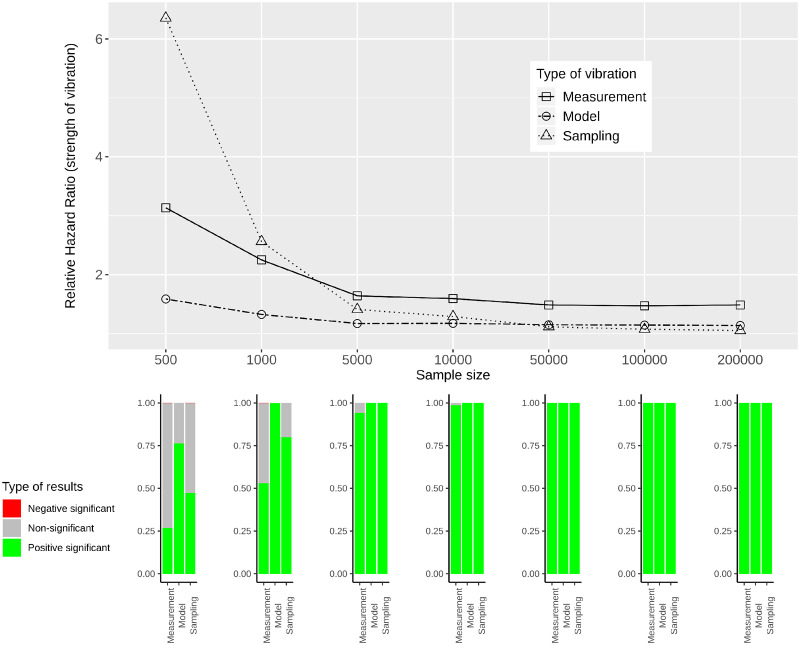
Measurement, model and sampling vibration for different sample sizes (top panel), and bar plots showing the type of results in terms of significance of estimated effects (bottom panel) for the association of heart disease with mortality